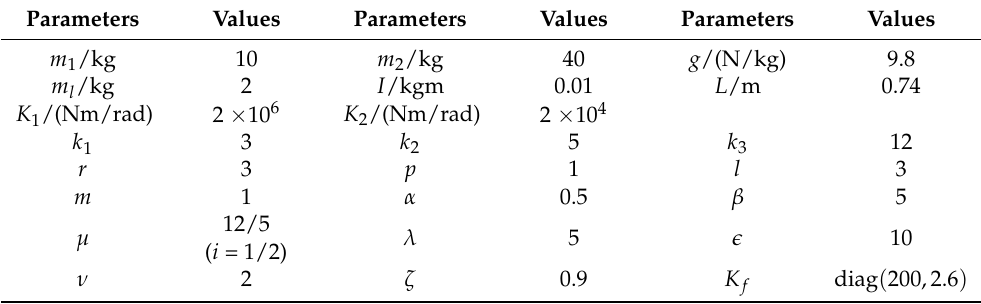
Table 3. System and controller parameters.